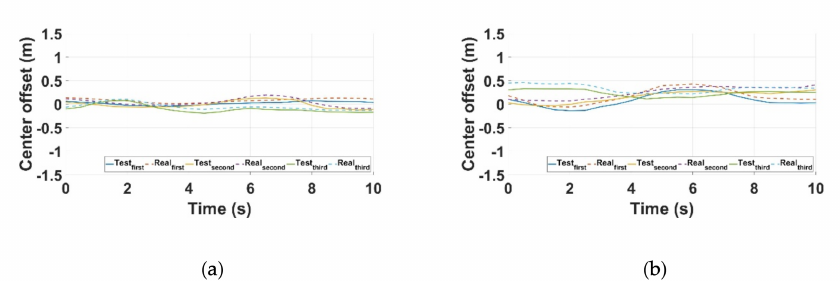
Figure 13. Comparison of theoretical values and real vehicle test results based on distance to the center of the lane: ( a ) scenario 4 and ( b ) scenario 5.